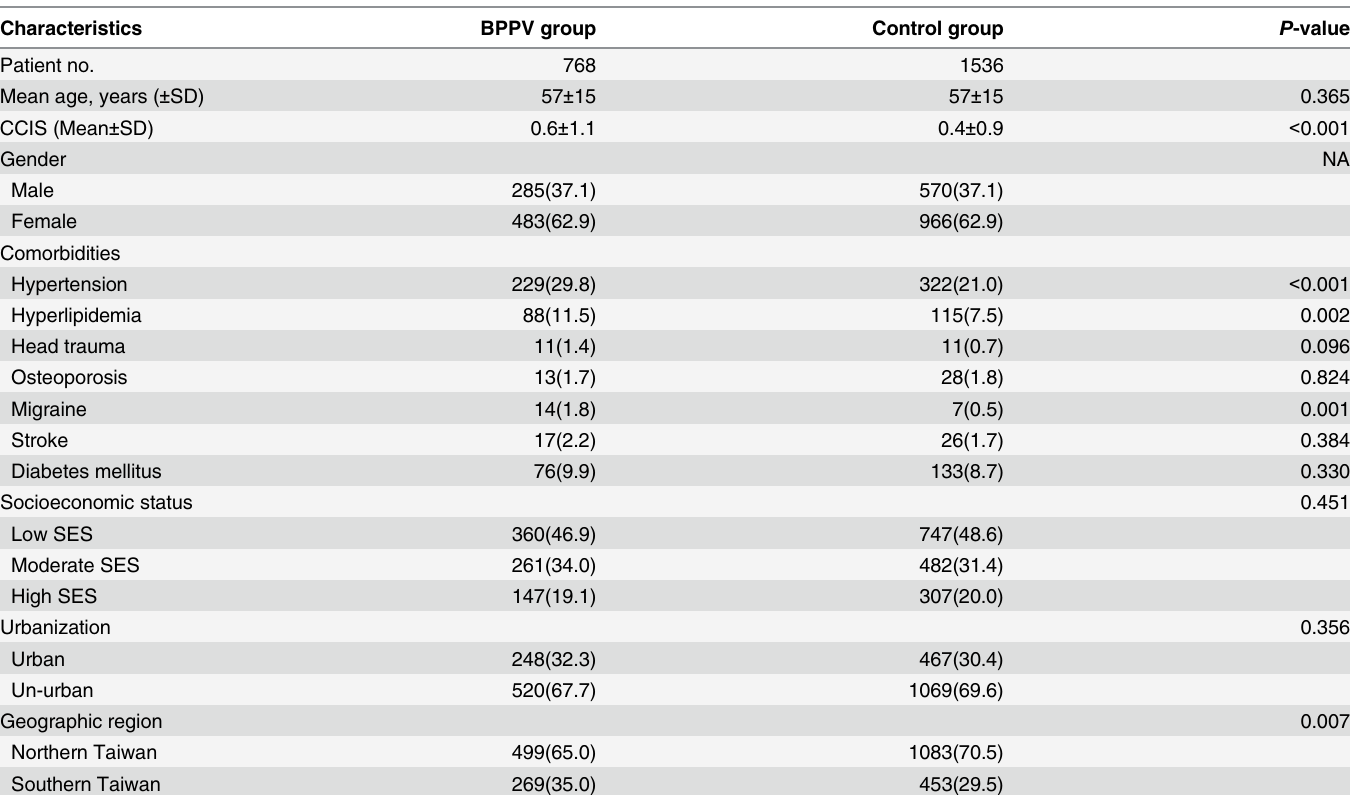
Table 1. Baseline characteristics.